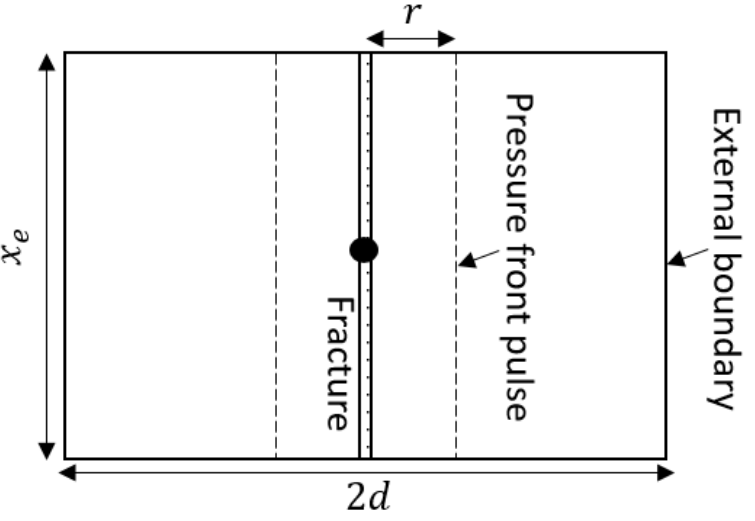
Figure 6. Example of hydraulic fracture in the center of a rectangular reservoir. The flow regime that occurs is linear. The normalized drawdown solutions is given by Equation (30). Representing this equation on a bi-logarithmic scale shows a half-slope linear flow reflecting the natural behaviour of the aquifer, followed by a deviation illus- trating the contribution of external boundaries to the aquifer hydrodynamics (Figure 7). pears at t Dye = 0.5 without providing details on the precision with which the pressure front is read. Taking the expression of the parameter t Dye , and setting it equal to 0.5 leads to Equation